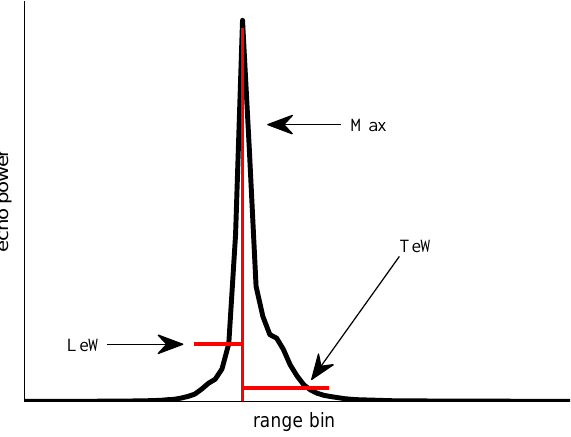
Fig. 3: Subset of the averaged waveform for first year ice, calculated as the mean of all waveforms Fig. 3. Subset of the averaged waveform for first-year ice, calculated retrieved over first year ice (specified in table 1). The approximate width of the leading edge and as the mean of all waveforms retrieved over first-year ice (specified trailing edge are indicated for visualization of these two waveform parameters. in Table 1). The approximate width of the leading edge and trailing edge are indicated for visualization of these two waveform parame-